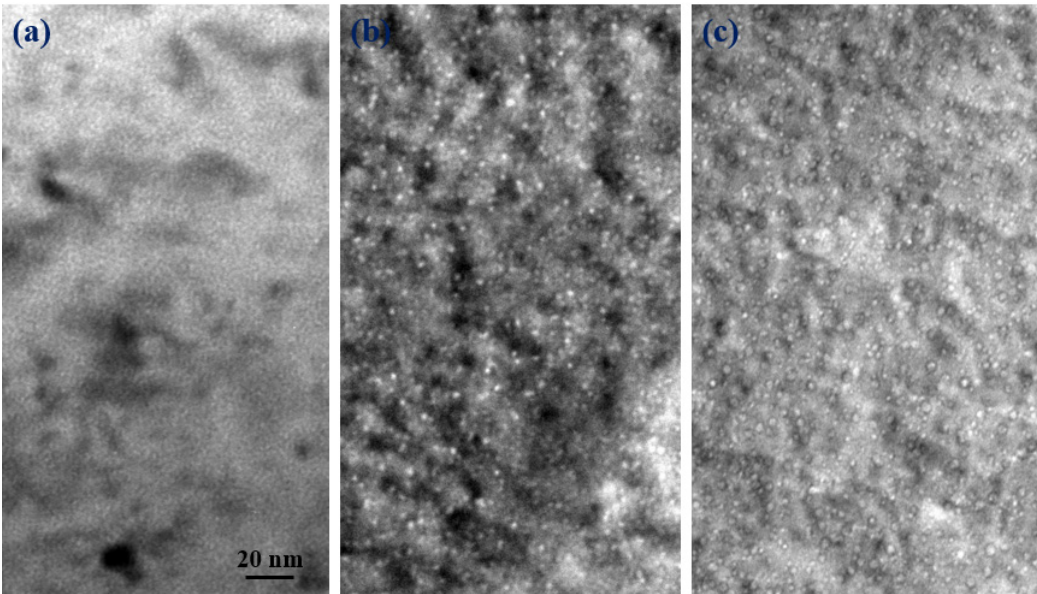
Figure 6. The micrographs of (5 × 10 16 He·cm − 2 ) helium single ion ( a ) and 5 × 10 16 He·cm − 2 /5 × 10 16 D·cm − 2 ( b ) and 5 × 10 16 He·cm − 2 /1 × 10 17 D·cm − 2 ( c ) helium/deuterium sequential-ion irradiated specimens.